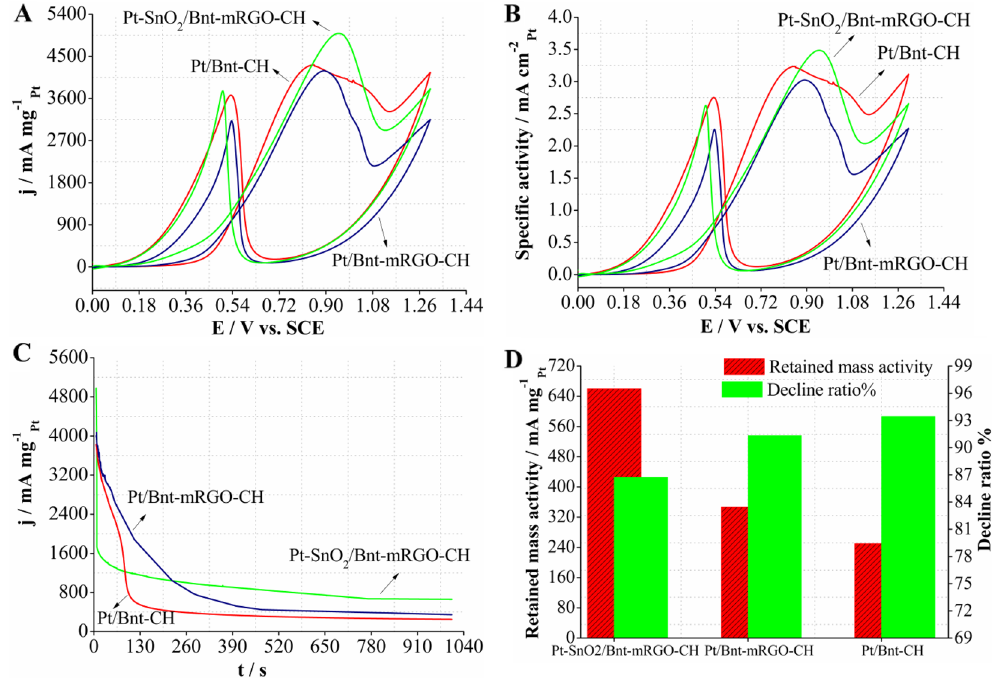
Figure 4. ( A ) The mass activity, ( B ) the specific activity and ( C ) the chronoamperometric curves of the catalysts in sulfuric acid 0.5 M and methanol 0.72 M. ( D ) the retained mass activity and activity decline ratio of the catalysts after 1000